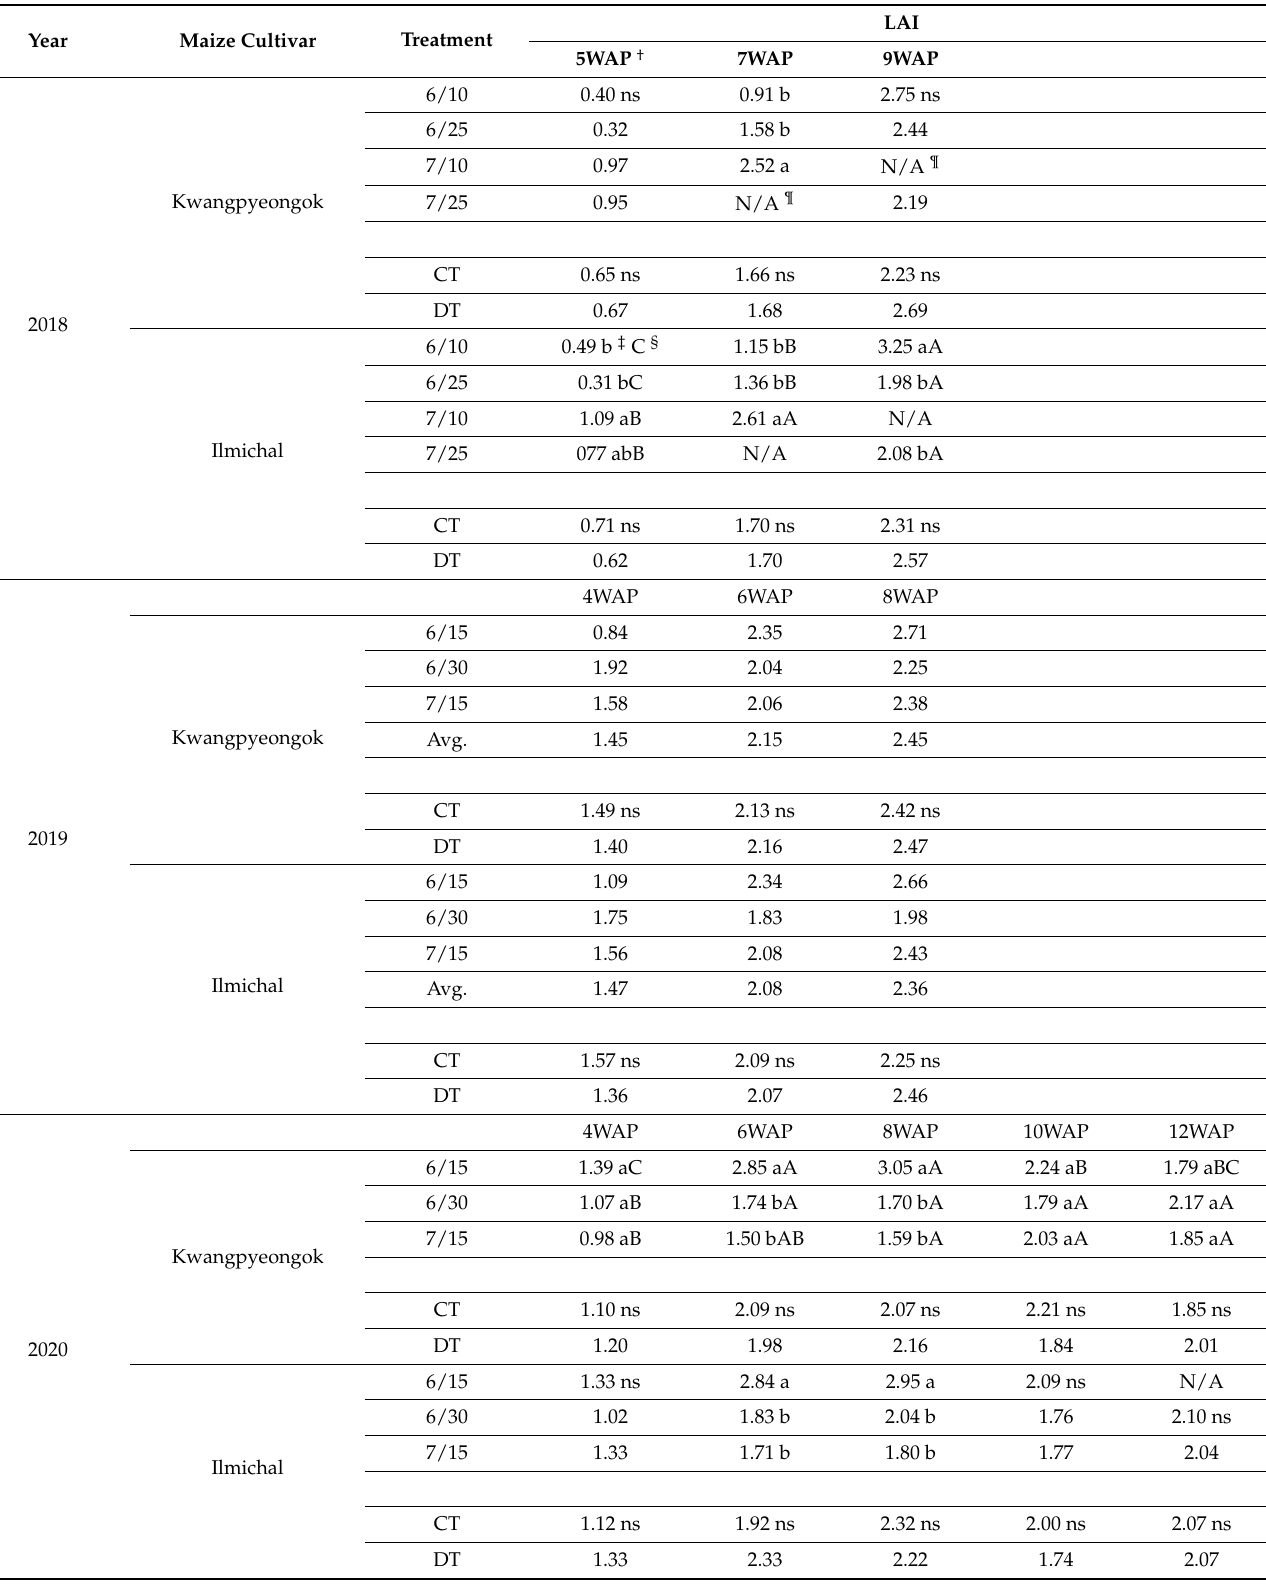
Table 4. LAI of two maize cultivars (Kwangpyeongok and Ilmichal), as affected by the planting date (6/10, 6/25, 7/10, and 7/25 in 2018; 6/15, 6/30, and 7/15 in 2019–2021) and tillage practice (deep tillage, DT; conventional tillage,